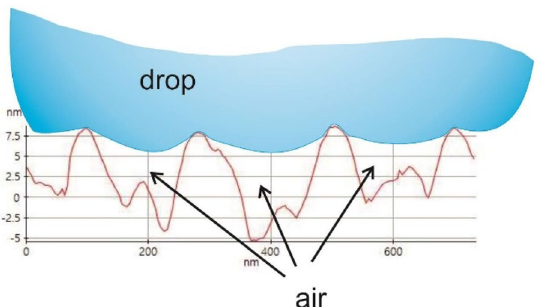
Figure 21. The nanoscale profile of the surface topography of the Ti + TiO 2 /Al 2 O 3 + TiO 2 coating on the AE42 alloy substrate obtained by the AFM analysis according to Fig. 1b together with the Cassie-Baxter wetting mechanism